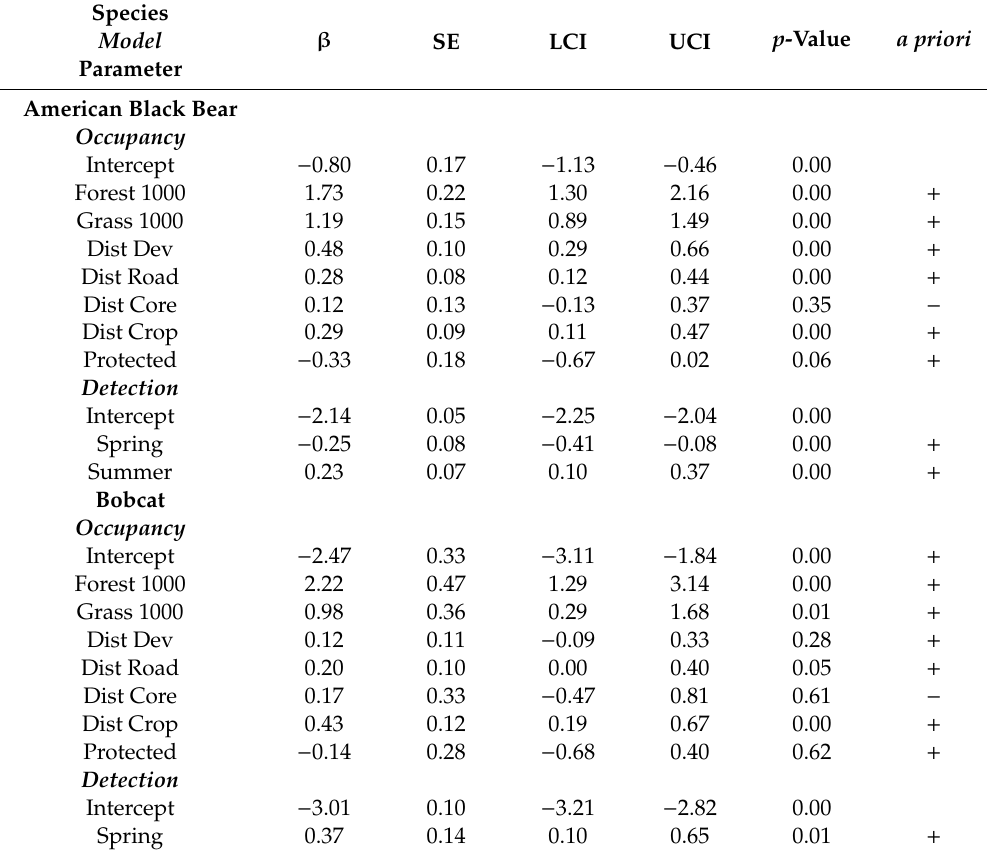
Table 1. Estimated beta coe ffi cients ( β ) with standard errors (SE), 95% lower and upper confidence intervals (LCI, UCI), p -values, and a priori predictions for covariate e ff ects from the top-ranking occupancy model, explaining variations in occupancy and detection e ff ects of land cover and anthropogenic covariates on the probability of site use by sensitive mammals from 1591 camera trap locations across an urban to rural gradient, northern Virginia, 2012–2018. Species β SE LCI UCI p -Value a